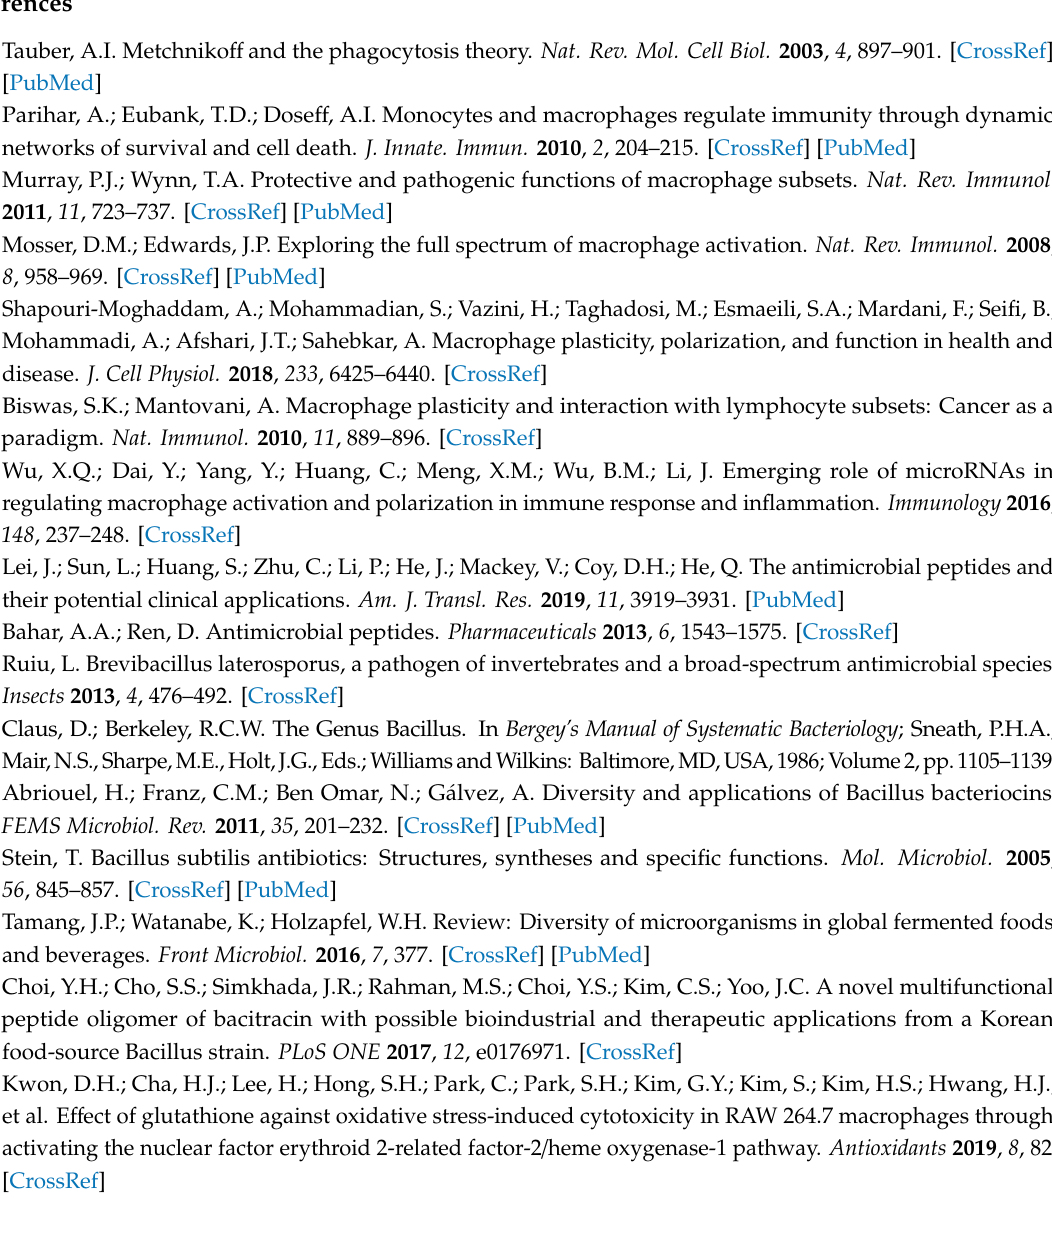
Table S1: Primary and secondary antibodies used for immunoblotting. Figure S1: Histogram shows the log2-fold change of each genes in expression between untreated cells and 88.0 µ M CSP32-treated cells. Figure S2: CPS32-mediated M1 macrophage polarization regulates by PLC signaling